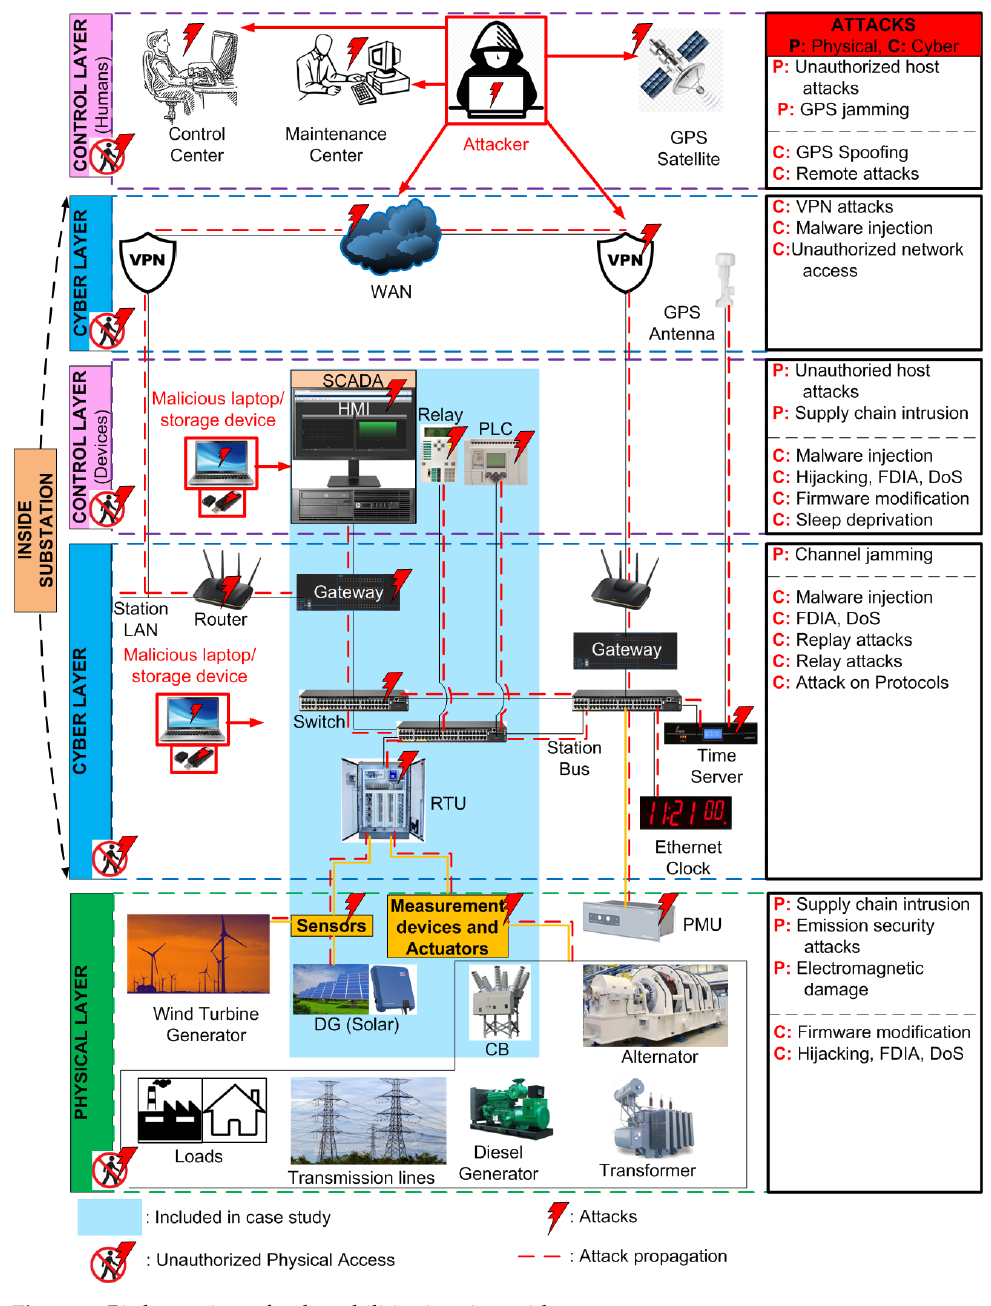
Figure 2. Bird-eye view of vulnerabilities in